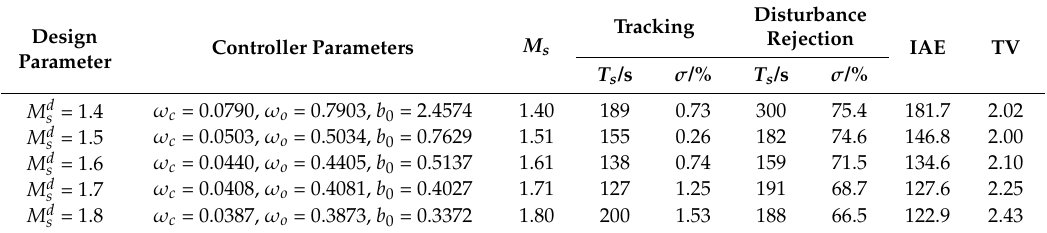
Figure 5. Output responses for different values of the designed maximum sensitivity M d s . Table 1. ADRC controller parameters and performance indices under different designed maximum sensitivity M d s for G ( s ) = 1/(10 s + 1) 5